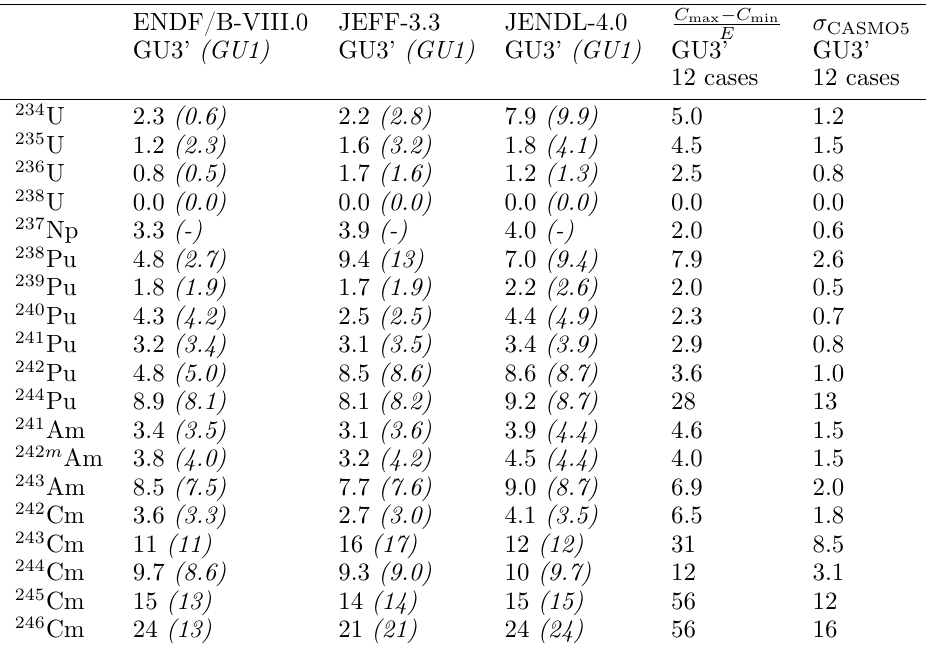
Table B.2. Uncertainties ∆ C from nuclear data libraries for the GU3’ sample for the actinide isotopic concentrations (CASMO5 v2.03 calculations). Numbers in italics are for the GU1 sample. For the 5 th and 6 th columns, see Section 5.2 for details. All values are